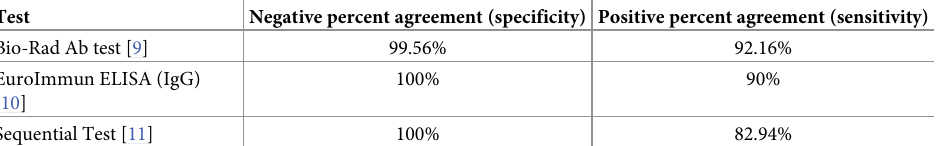
Table 1. Performance of serial antibody assays, King County, Washington anti-SARS-CoV-2 seroprevalence sur- vey, August